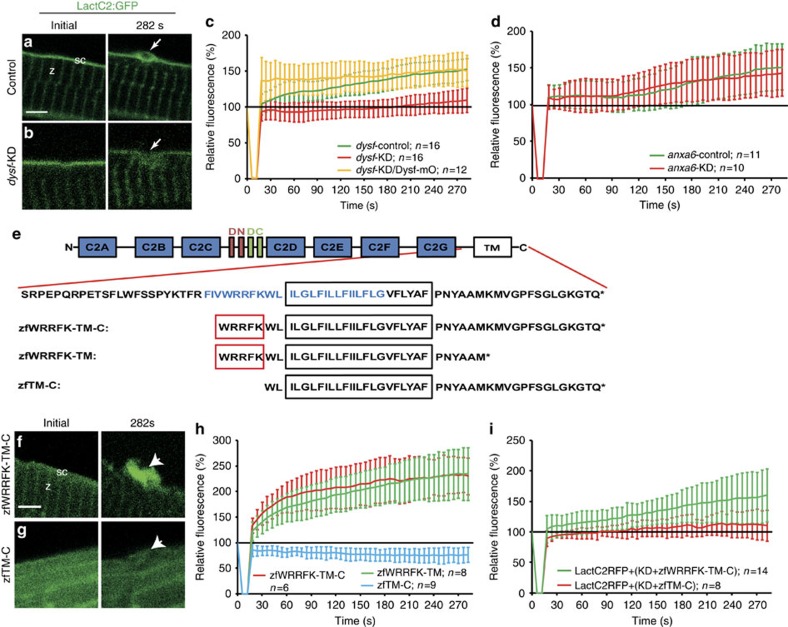
Five amino acid motif in Dysf is required for PS accumulation.(a,b) Before wounding, LactC2:GFP (green) localized to the sarcolemma (sc; a) and the Z-line (z; a) both in control (a) and knock-down (dysf-KD; b) myofibers. On injury, LactC2:GFP accumulated in controls (a, arrow) but not in dysf-KD myofibers (b, arrow). (c) Kinetics of LactC2:GFP accumulation in control-KD (green), dysf-KD (red) and dysf-KD embryos co-injected with mOrange1-DysfC (Dysf–mO, yellow). Lack of PS accumulation in dysf-KD myofibers was rescued by Dysf–mO, translation of which is not inhibited by dysf morpholino. (d) Knock-down of anxa6 (anxa6-KD) had no effect on PS accumulation (red) compared with controls (anxa6-control, green). (e) Domain structure of Dysf. (blue AA: predicted amphipathic helix). (f,g), On damage zfWRRFK-TM-C accumulates in the repair patch (f, arrow). No accumulation was observed for zfTM-C (g, arrow). (h) Accumulation kinetics of zfWRRFK-TM-C (red), zfWRRFK-TM (green) and zfTM-C (blue). A 5-AA motif (WRRFK, red box, e) is required for accumulation. (i) zfWRRFK-TM-C (red) but not zfTM-C (green) rescued PS accumulation in dysf-KD myofibers. In all charts, the change of fluorescence at the lesion is indicated as percentage relative to the undamaged state±s.d.). Scale bars, 4 μm (a,g–h), 3 μm (b).